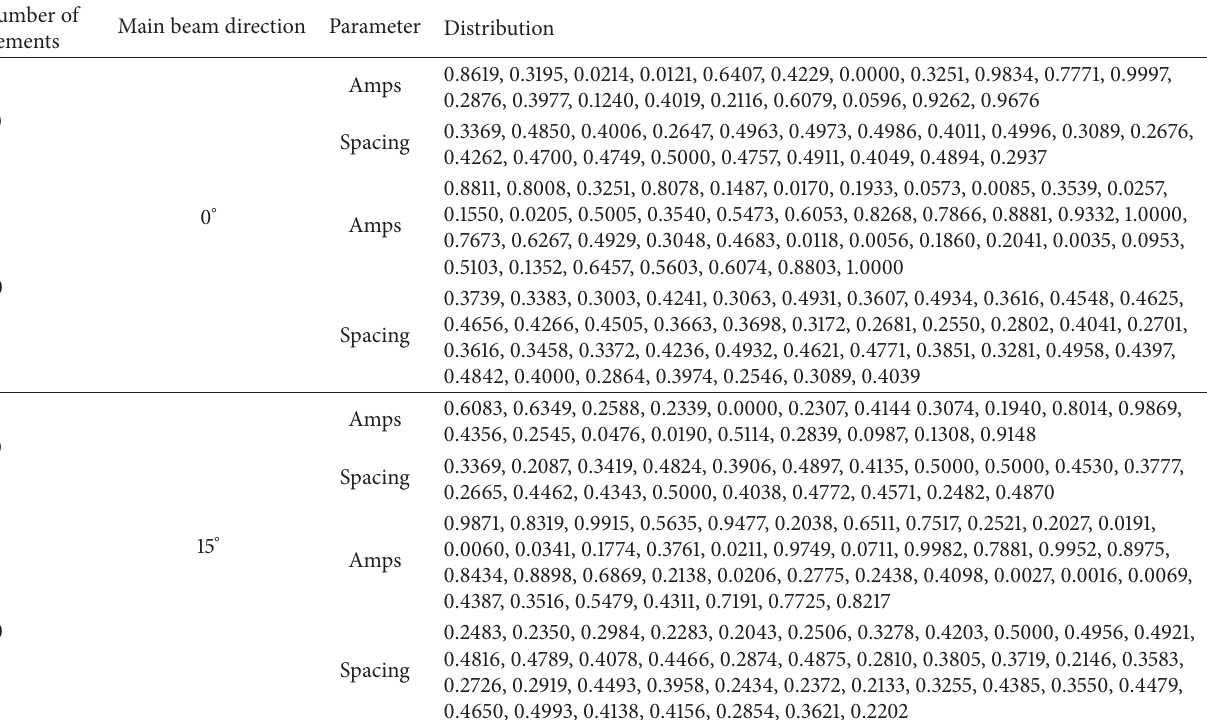
Table 2: Amplitude and interelement space distribution for Cases 3 and